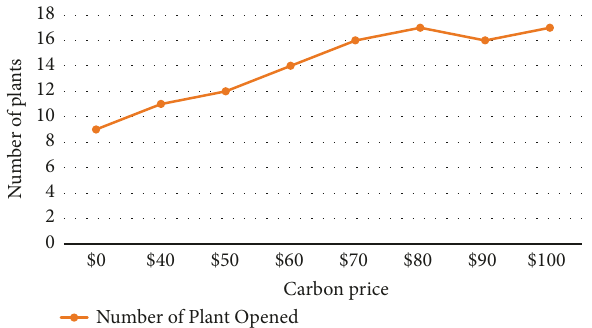
Figure 4: Number of plants opened with carbon price